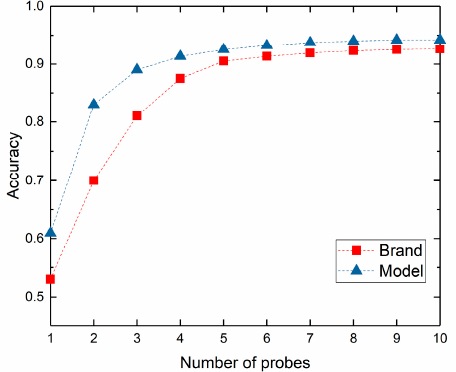
Figure 7. The identification accuracy variety with the increasing of protocol probes in order.